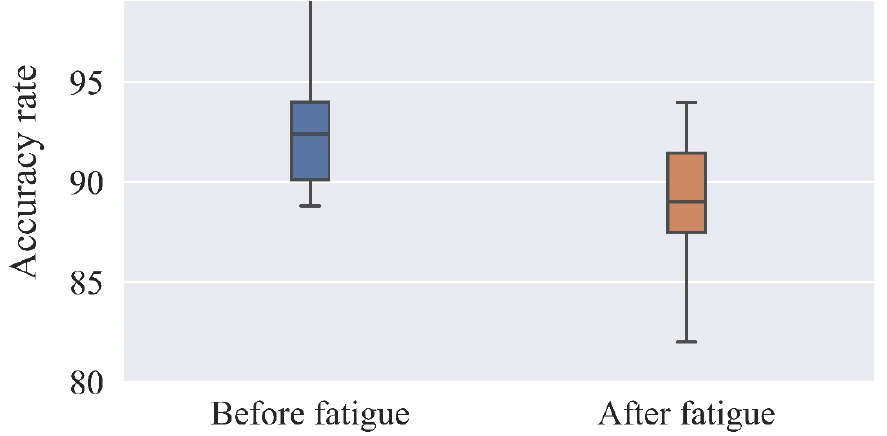
Figure 7. Reaction time before and after brain fatigue.